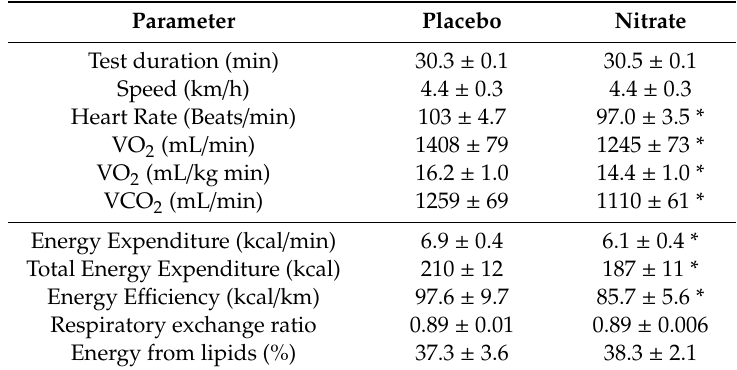
Table 2. Parameters of an exercise test at 60–70% of maximal heart rate after intake of placebo or a nitrate-supplemented